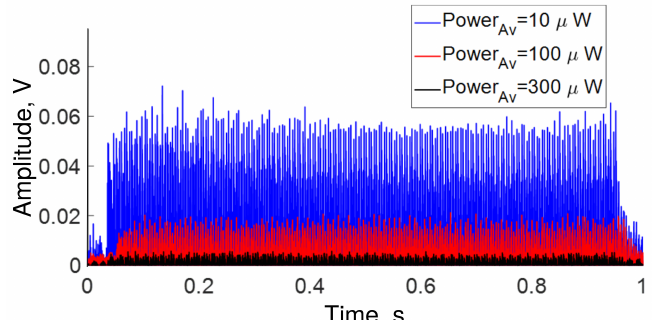
Figure 4. All frequencies detected during ∼ 1 s by OFSI for several average power values adjusted by QWR angle α (see Figure 1).